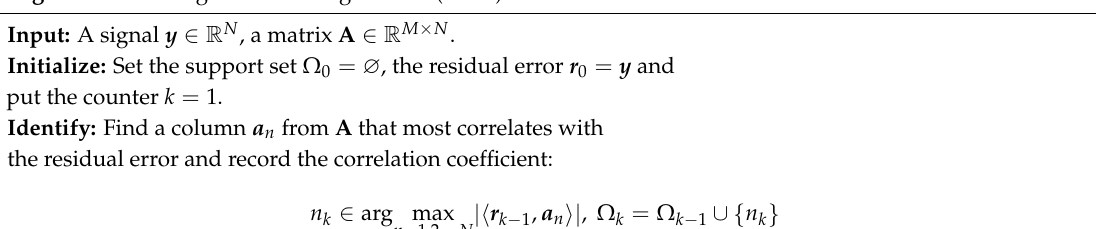
Algorithm 1 Orthogonal Matching Pursuit